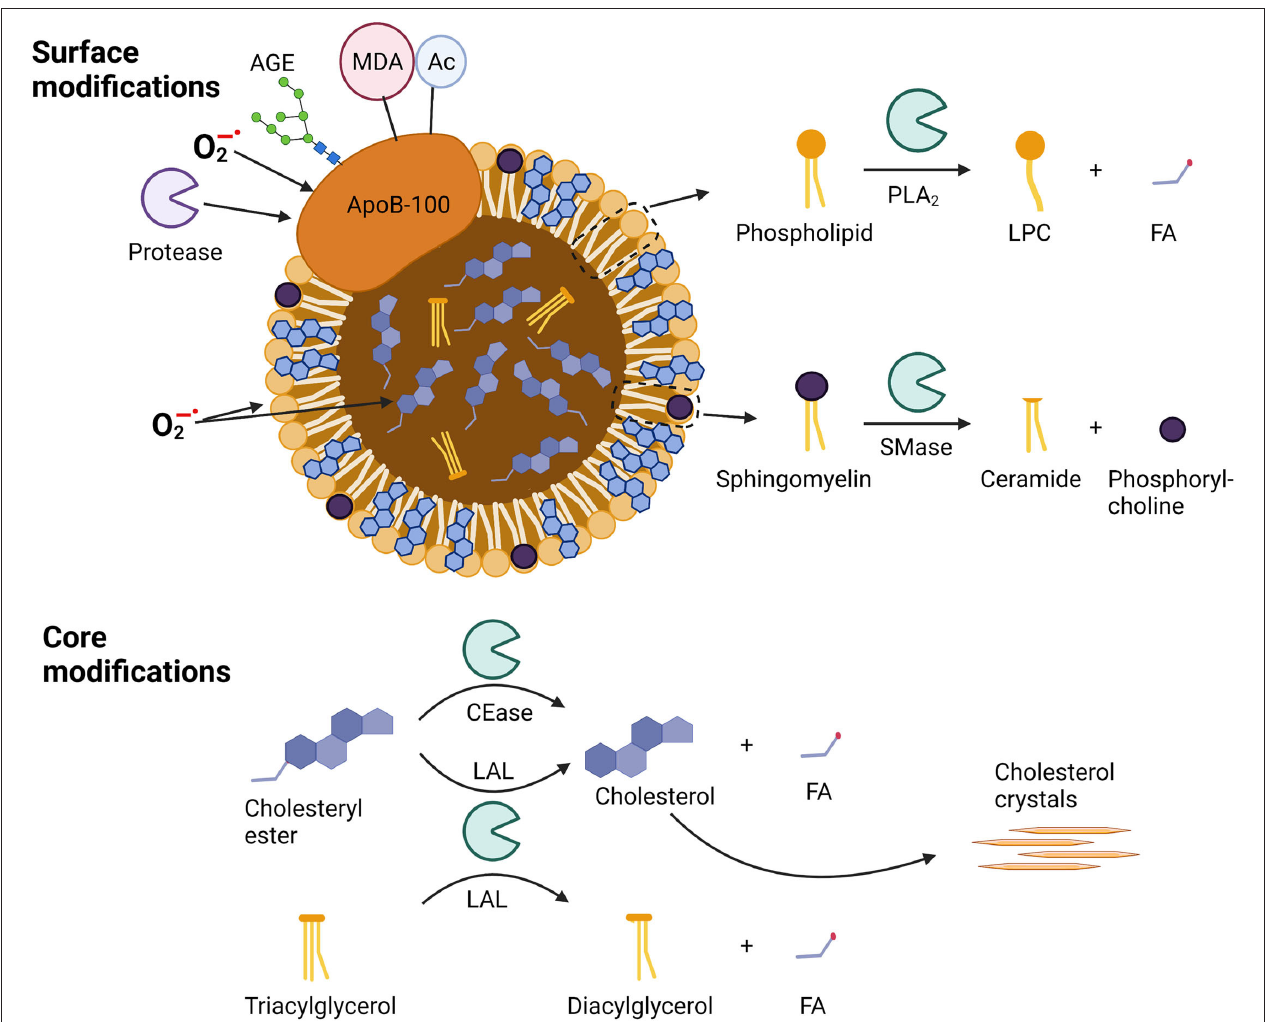
FIGURE 1 | Sites of modification in apoB-100-containing lipoproteins. Surface modifications include modifications of apo-B100 by proteases, oxidation by superoxide anion radicals (O − 2 ), glycosylation by advanced glycosylation end-products (AGEs), binding of malondialdehyde (MDA) adducts, or acetylation (Ac). Phospholipids can be oxidized as well as hydrolyzed by phospholipase A2 (PLA 2 ) to lysophosphocholine (LPC) and a fatty acid (FA), while sphingomyelins can be hydrolyzed by sphingomyelinase (SMase) to yield ceramides and phosphorylcholines. Core modifications include cholesteryl ester oxidation and well as hydrolysis by cholesterol esterase (CEase) or lysosomal acid lipase (LAL) to yield unesterified cholesterol and a fatty acid (FA). Triacylglycerol can be hydrolyzed by LAL to diacylglycerol and a fatty acid